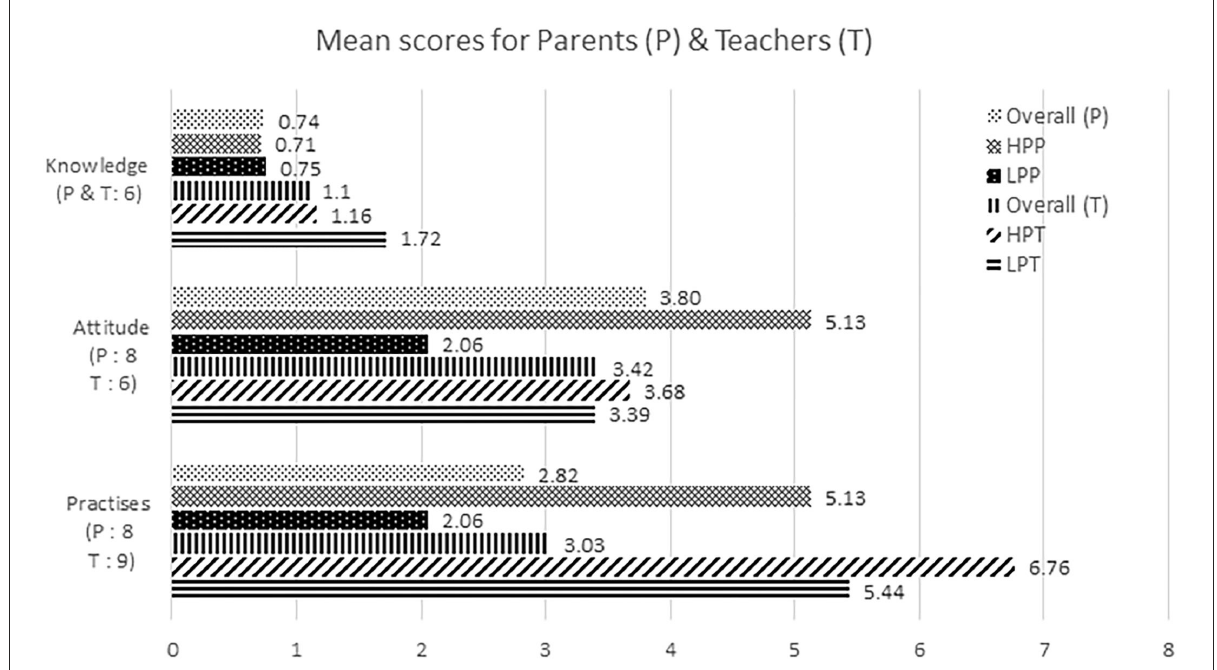
FIGURE1 KAP scores of parents and teachers. The highest scores that can be scored by the parents (P) and teachers (T) for each domain are denoted in brackets, respectively. HPP, High practise parents; LPP, Low practise parents; HPT, High practise teachers; LPT, Low practise teachers. (Between high and low practise